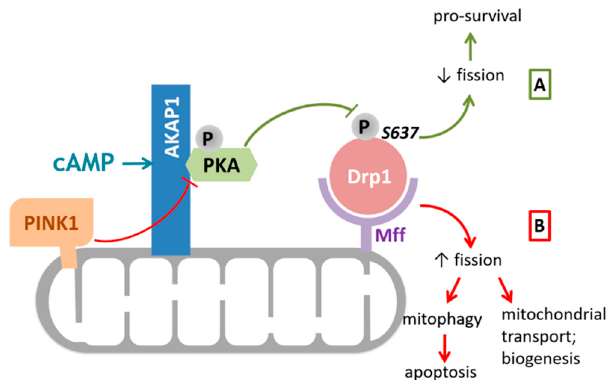
Figure 2. AKAP1 modulates mitochondrial fission by regulating Drp1 activity via PKA. PKA can be recruited to the OMM by binding to AKAP1. ( A ) Drp1 is recruited to the mitochondria via Mff where, upon activation by cAMP, PKA deactivates Drp1 through phosphorylation at Ser637. The resulting opposed mitochondrial fission promotes cell survival under pathological conditions such as ischemia and reperfusion injury. ( B ) PINK1 can dissociate the AKAP1–PKA complex in a kinase activity dependent manner and therefore blocks the anti-fission role of AKAP1–PKA. Increased mitochondrial fission through unopposed Drp1 activation is important for the initiation of mitophagy and apoptosis, as well as for mitochondrial biogenesis and transport. Abbreviations: AKAP1, A kinase anchoring protein 1; Drp1, dynamin related protein 1; cAMP, cyclic adenosine monophosphate; Mff, mitochondrial fission factor; PKA, protein kinase A; PINK1, PTEN-induced kinase 1.